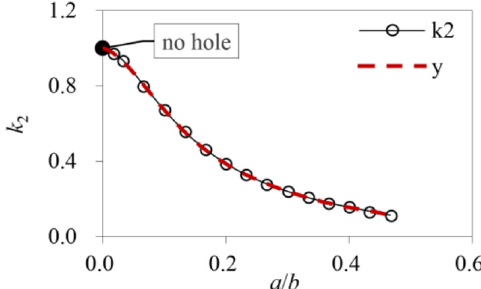
Fig. 14. Reduction coef fi cient k 1 of square plate with circular hole.